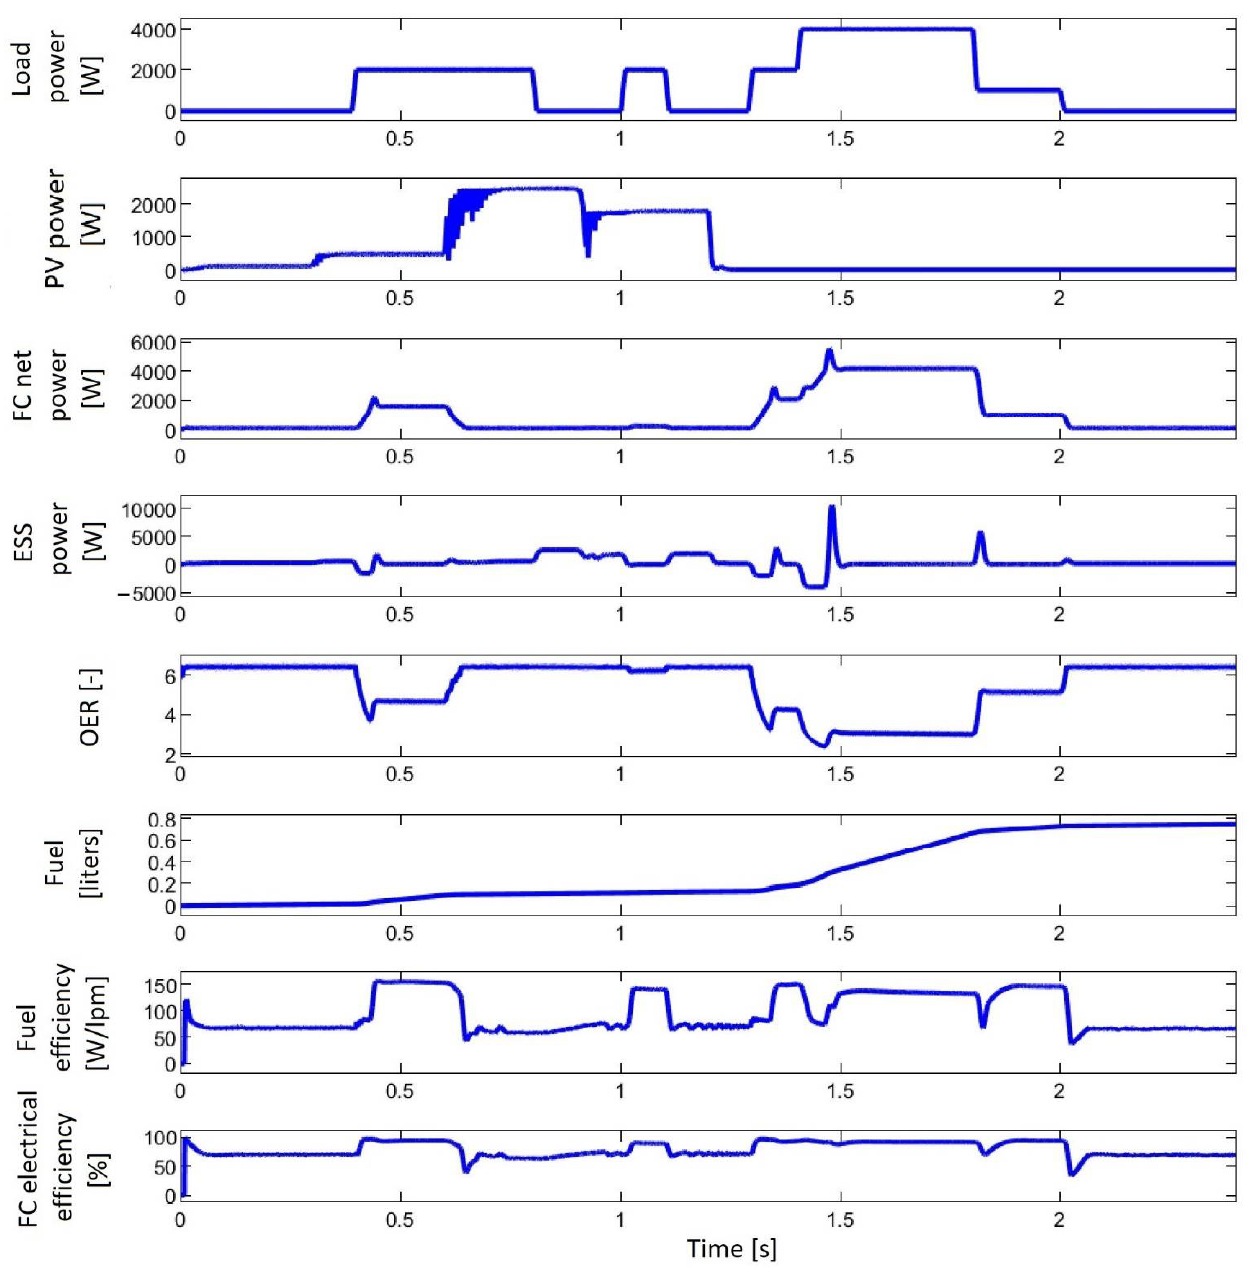
Figure 9. The behavior of the PV/FC/ESS system using strategy S0 in the scenario SC2.